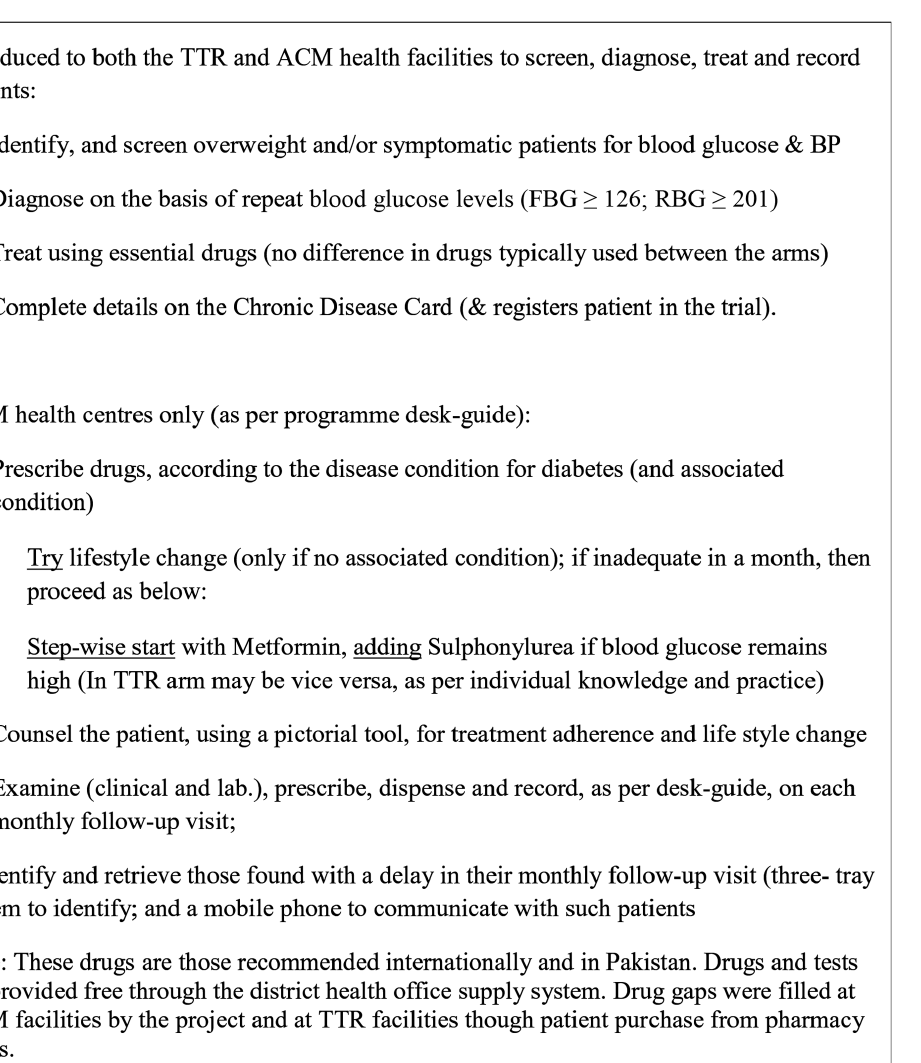
Figure 1. Diabetes intervention (ACM) and control (TTR-only) care package details. ACM = additional case management. BP = blood pressure. FBG = fasting blood glucose. RBG = random blood glucose. TTR = testing, treating, and